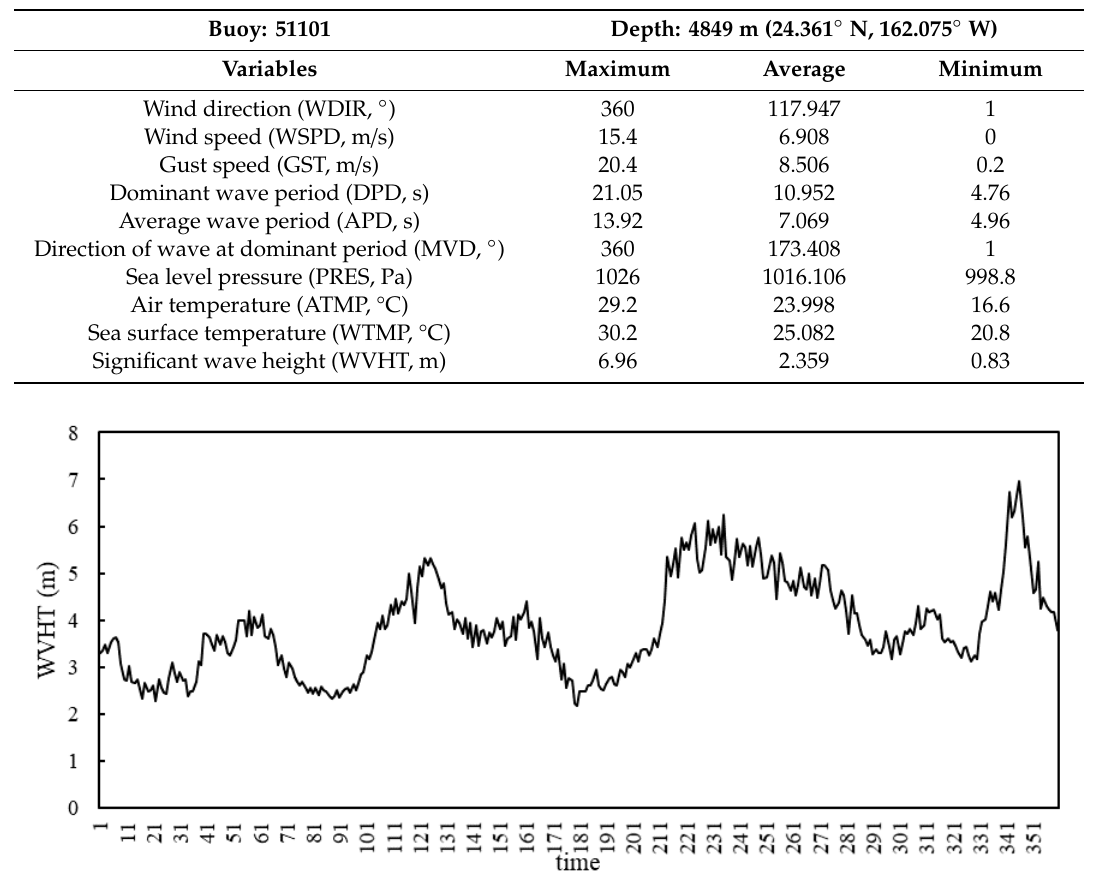
Figure 2. Time series records of WVHT in buoy 51101.